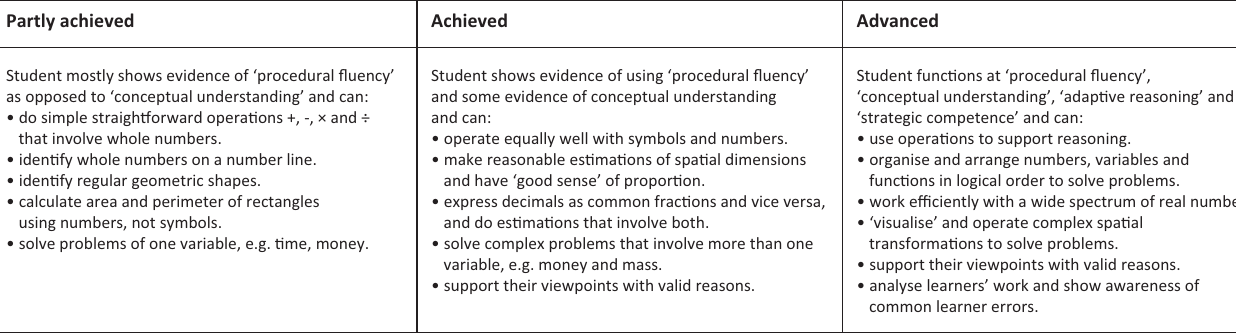
FIGURE 4: Illustrative PrimTEd mathematics performance level descriptors.